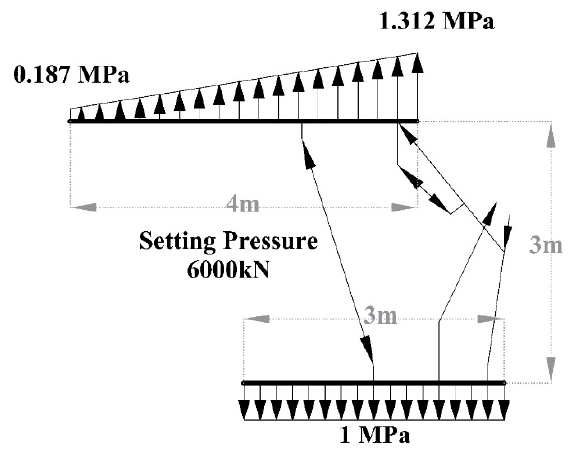
Figure 7. Pressure distribution for modeling shield support.